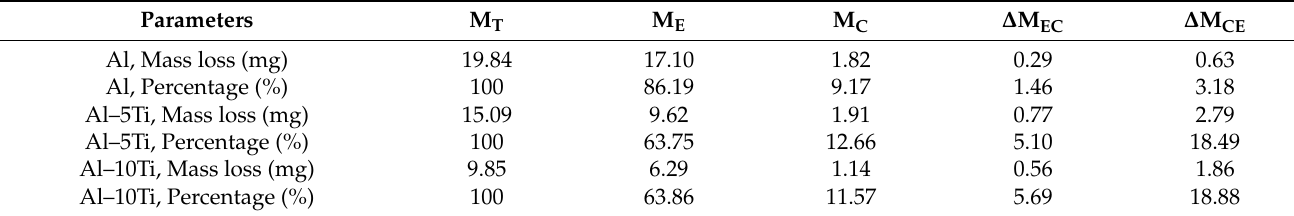
Table 3. Mass loss of Al, Al–5Ti, and Al–10Ti sample caused by pure cavitation erosion (M E ), pure corrosion (M C ), corrosion promoted by cavitation erosion ( ∆ M EC ), cavitation erosion promoted by corrosion ( ∆ M CE ), and the total mass loss (M T ) after 300 min in 3.5 wt.% NaCl